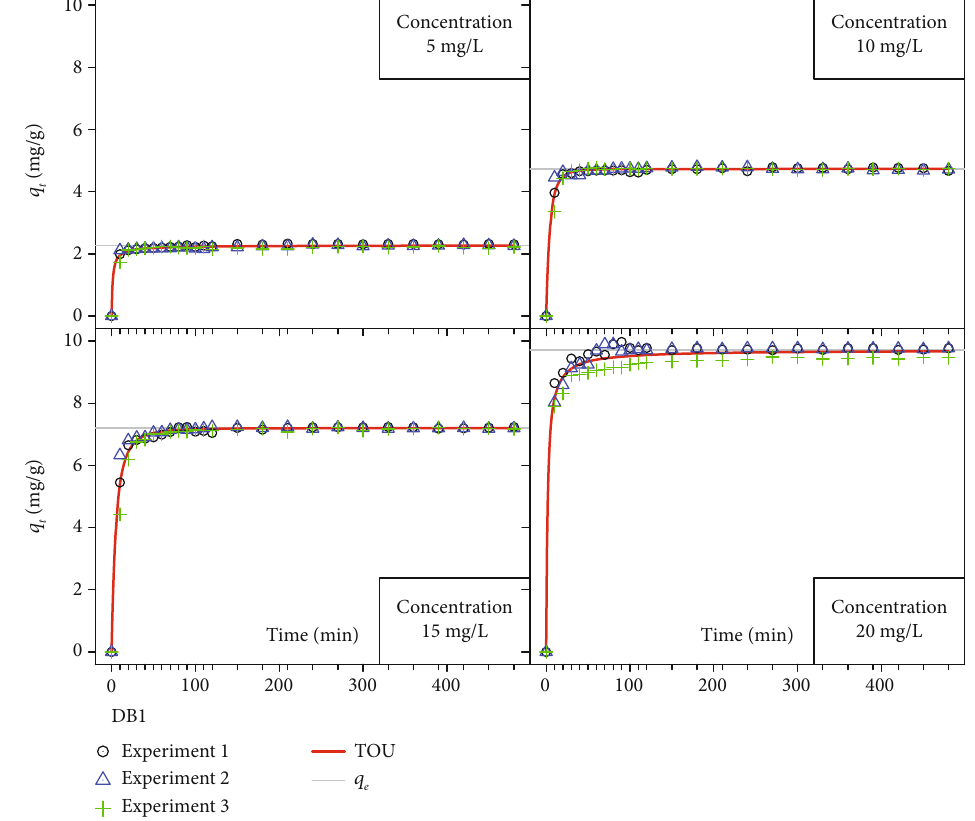
Figure 6: Experimental adsorption kinetics for the removal of DB1 by Pec-Ca at di ff erent initial dye concentrations and the theoretical curves generated by applying the TOU model to the experimental